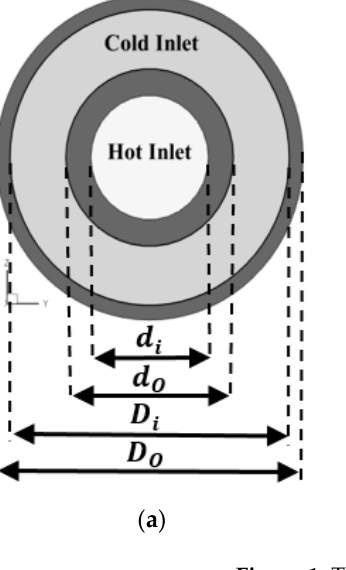
Figure 1. The schematics of the geometries of the helical double pipe heat exchanger and employed swirl generator; ( a ) the 2D-view of the heat exchanger’s cross-section with geometric factors, and ( b ) the 3D-view of the computational